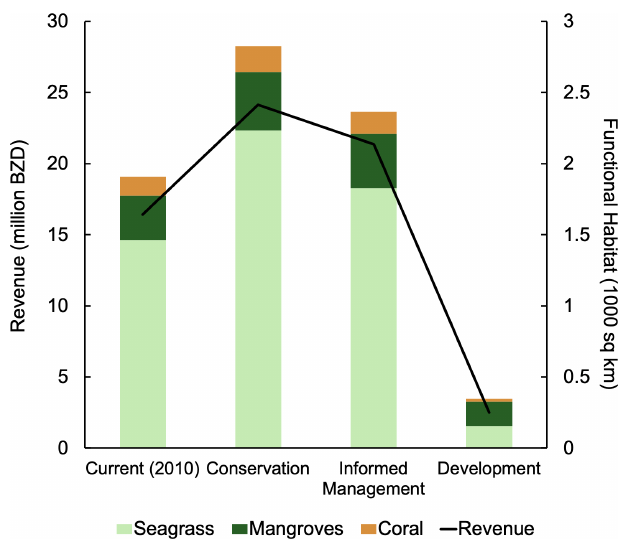
Fig. 2 . Lobster revenue and functional habitat modeled under the current scenario (2010) and three future scenarios of coastal zone use (2025) in Belize.